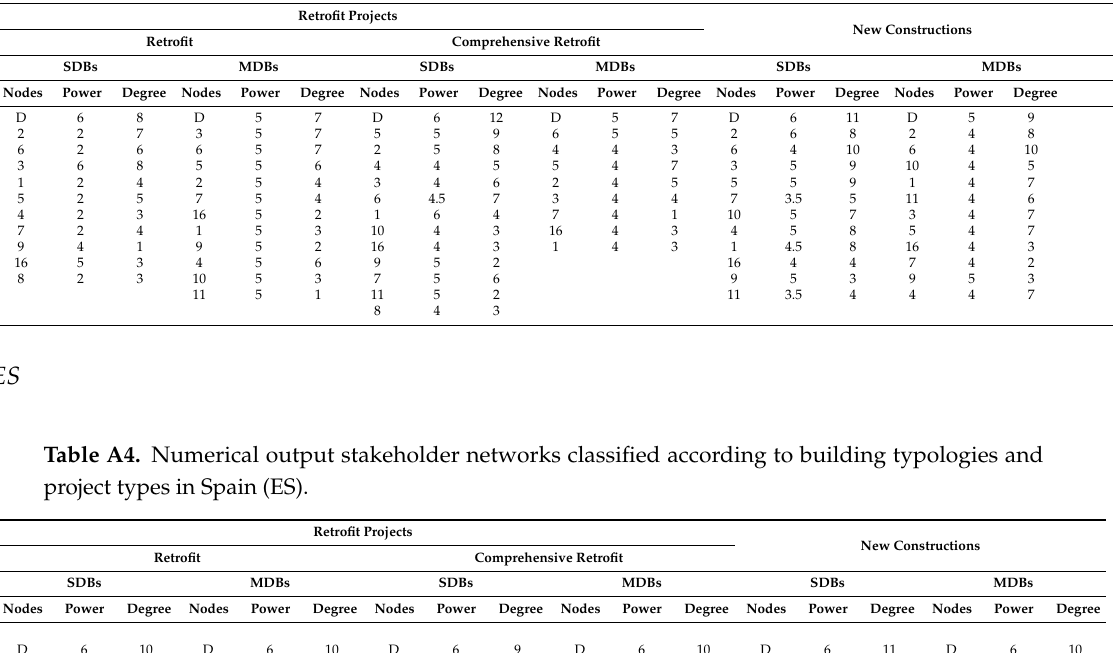
Table A3. Numerical output stakeholder networks classified according to building typologies and project types in Italy (IT).